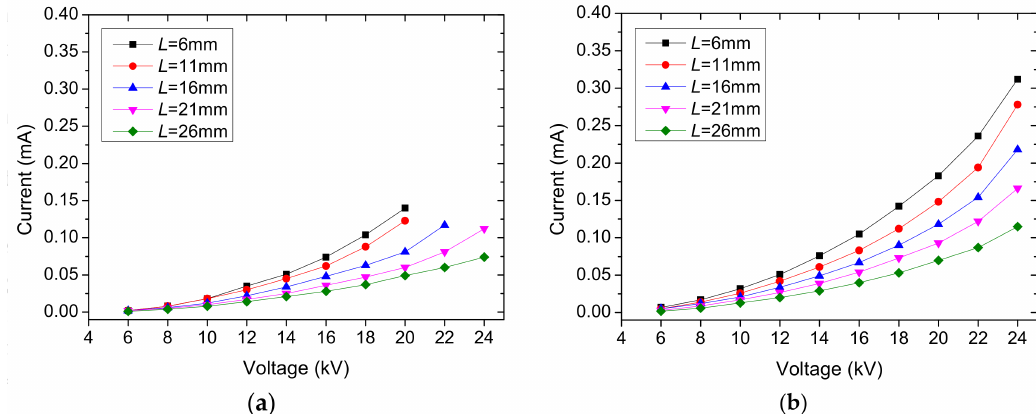
Figure 7. Variation of discharge current with the applied voltage with different needle-ring distances for three needles: ( a ) positive corona discharge; and ( b ) negative